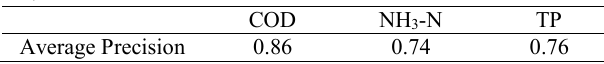
Table 2. Precision of the water quality SVM classification models